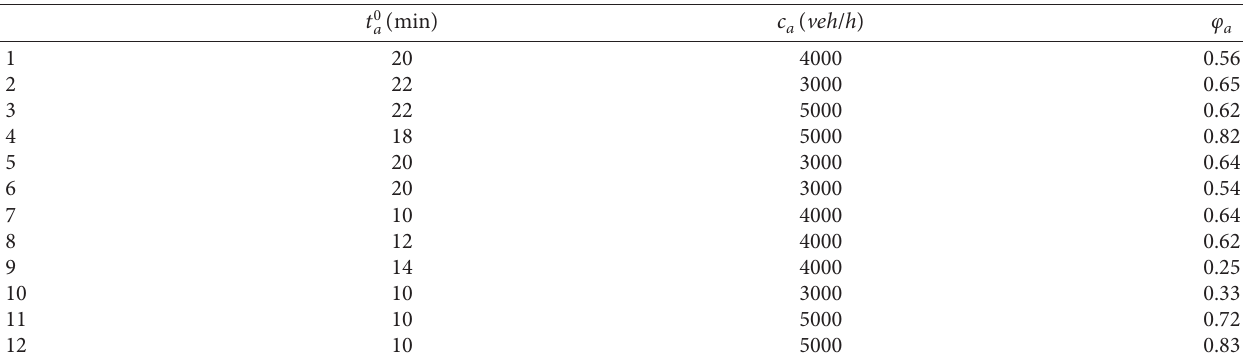
Table 6: Parameter